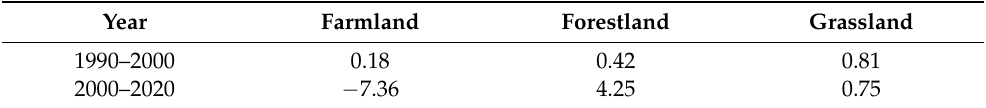
Table 8. Dynamic degree of the ESVs of cultivated land, forestland, and grassland in Shaanxi Province from 1990 to 2020 (in